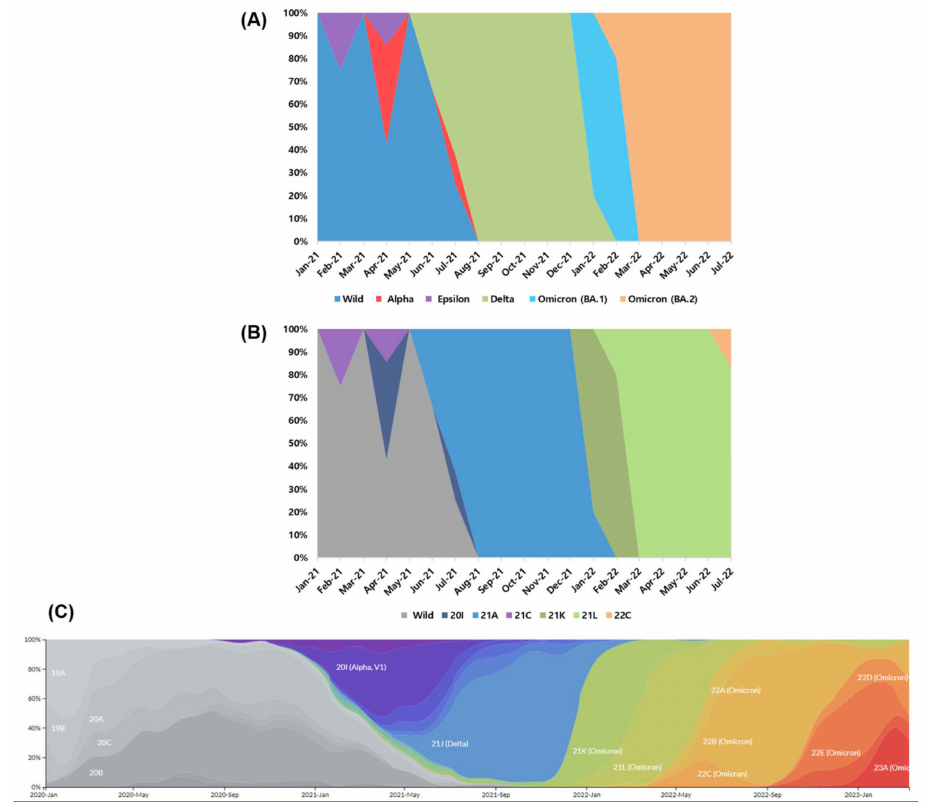
Figure 3. Time course distribution of sequenced SARS-CoV-2 strains in South Korea between January 2021 and July 2022. ( A ) The World Health Organization (WHO) and ( B ) NextStrain classi- fication systems were applied. ( C ) A plot including approximately 4000 genomes collected from January 2020 to March 2023 globally (https://nextstrain.org/ncov/gisaid/global/all-time, accessed on 1 February